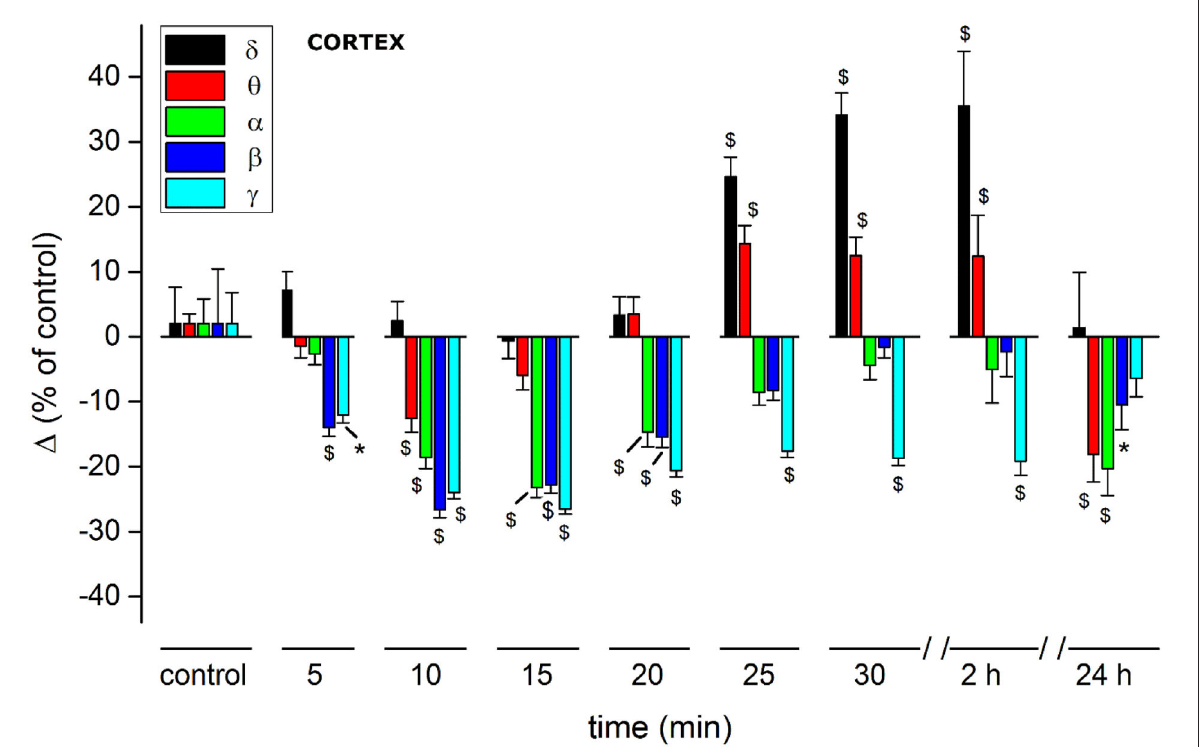
FIGURE6 Histogram summarizing average relative % changes of δ , θ , α , β , γ , amplitude, measured as FFT area relative to a 5-min window and recorded in somatosensory cortical area. Histograms at control are exclusively functional to mate EEG color bands with corresponding error bars. Values correspond to % ± s.e. Original data are reported in Supplementary materials and Table 2. Two-way ANOVA with Dunnet test used to compare the control EEG amplitude of groups before treatment with values after treatment. * p < 0.05; $ p < 0.01.